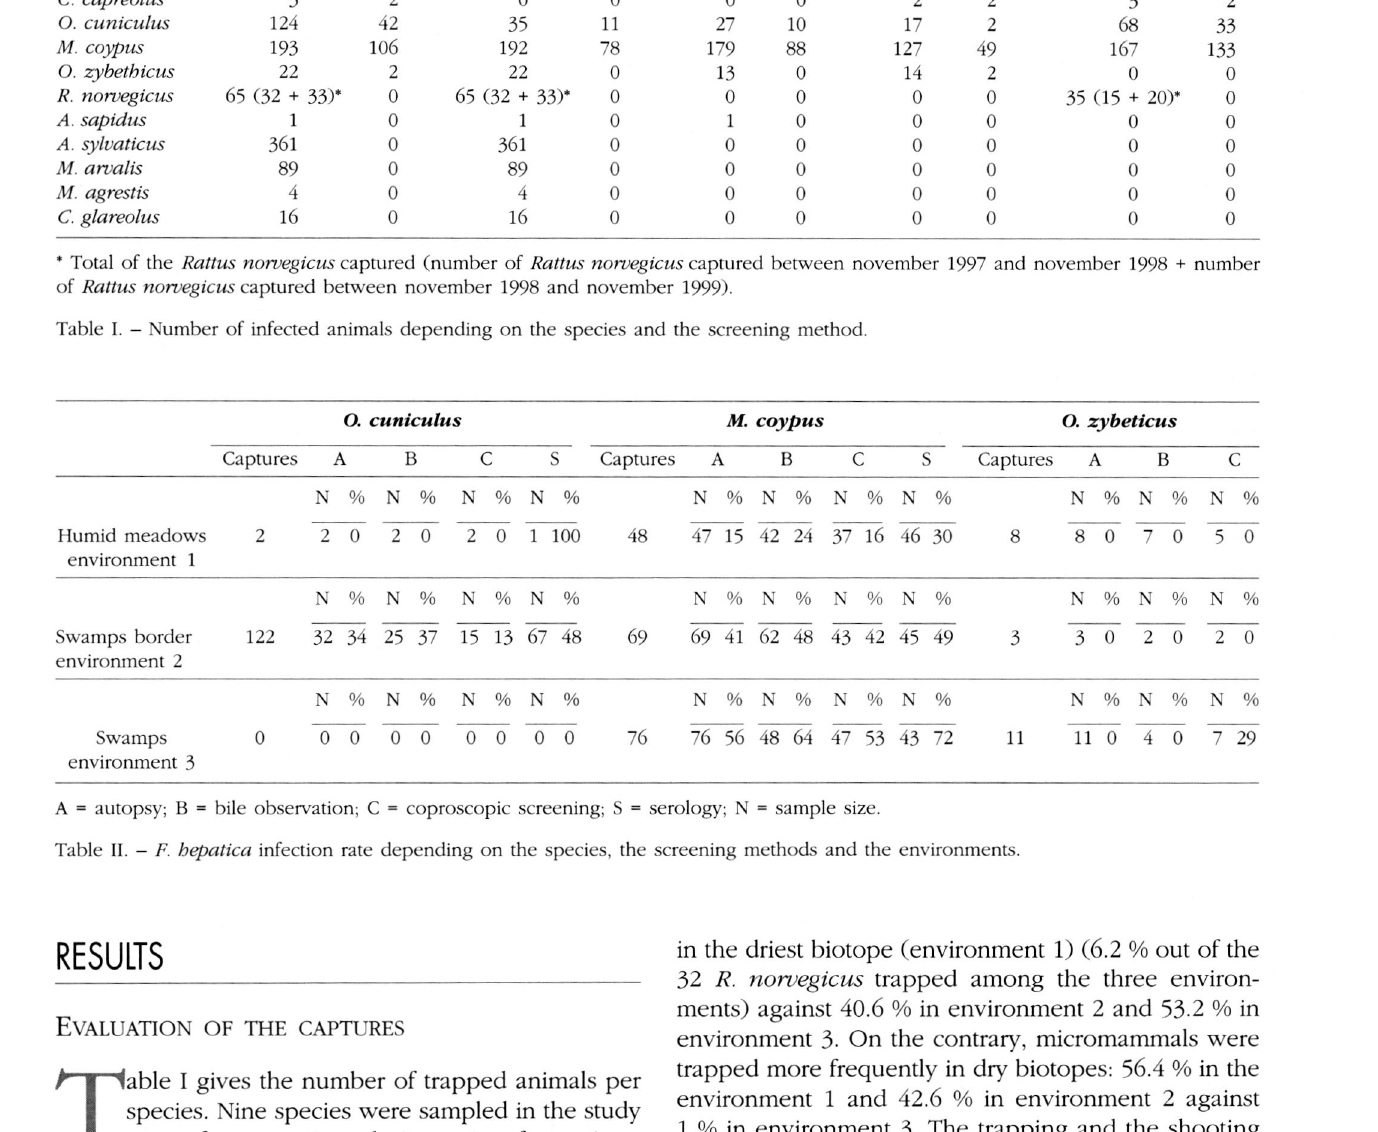
Table II. - F. hepatica infection rate depending on the species, the screening methods and the